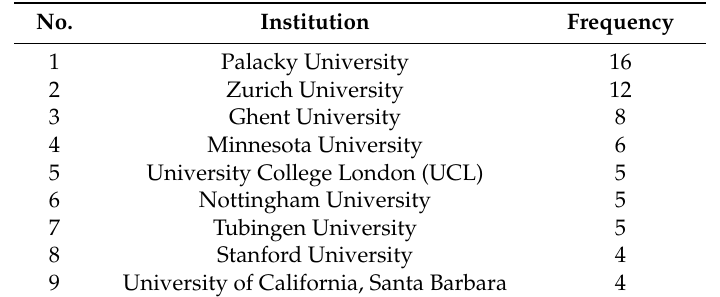
Table 5. Top ranked institutions.